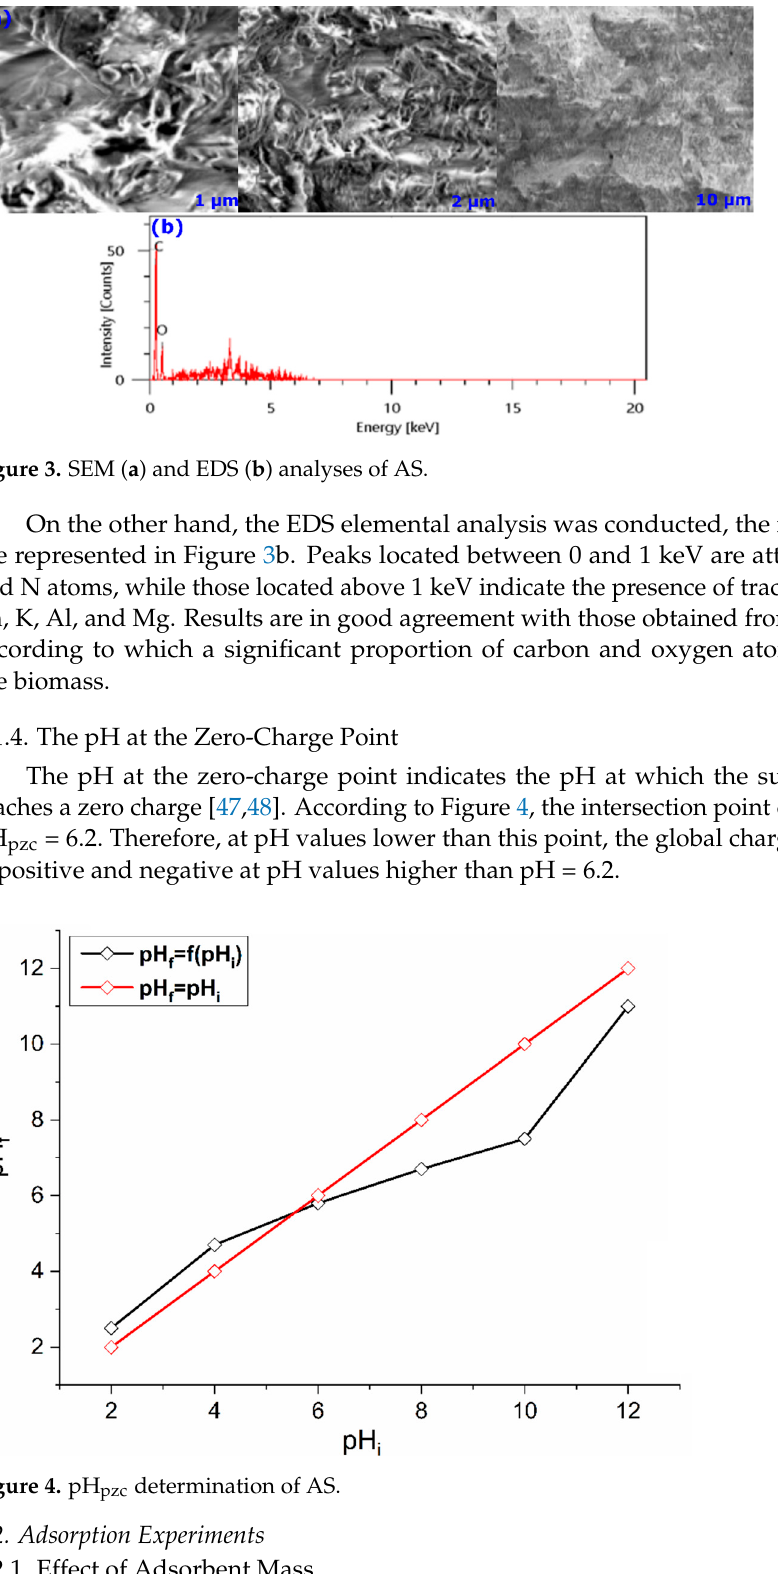
Figure 4. pH pzc determination of AS.